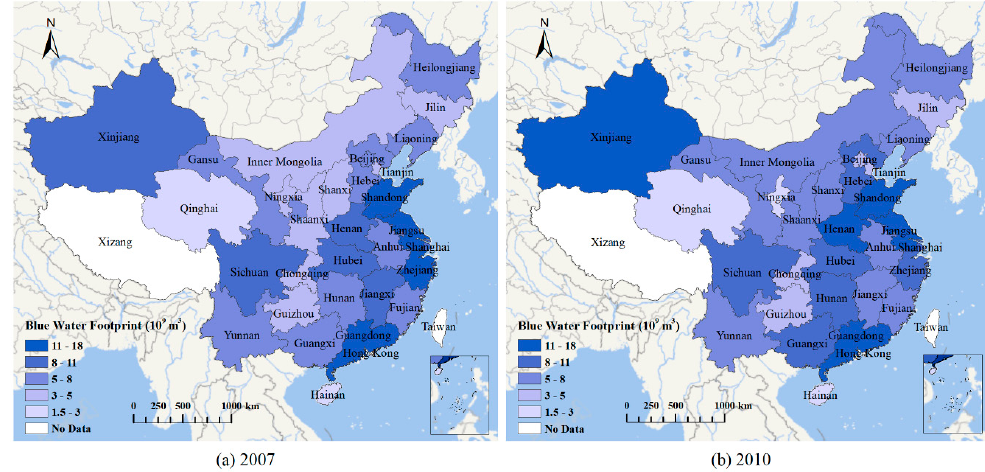
Figure 1. Spatial distribution of China’s WF for the years, 2007 and 2010.